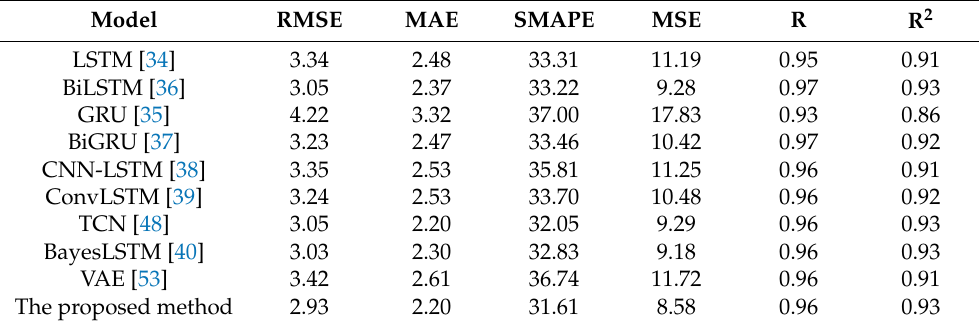
Table 2. Accuracy evaluation of prediction results of each model on temperature dataset.